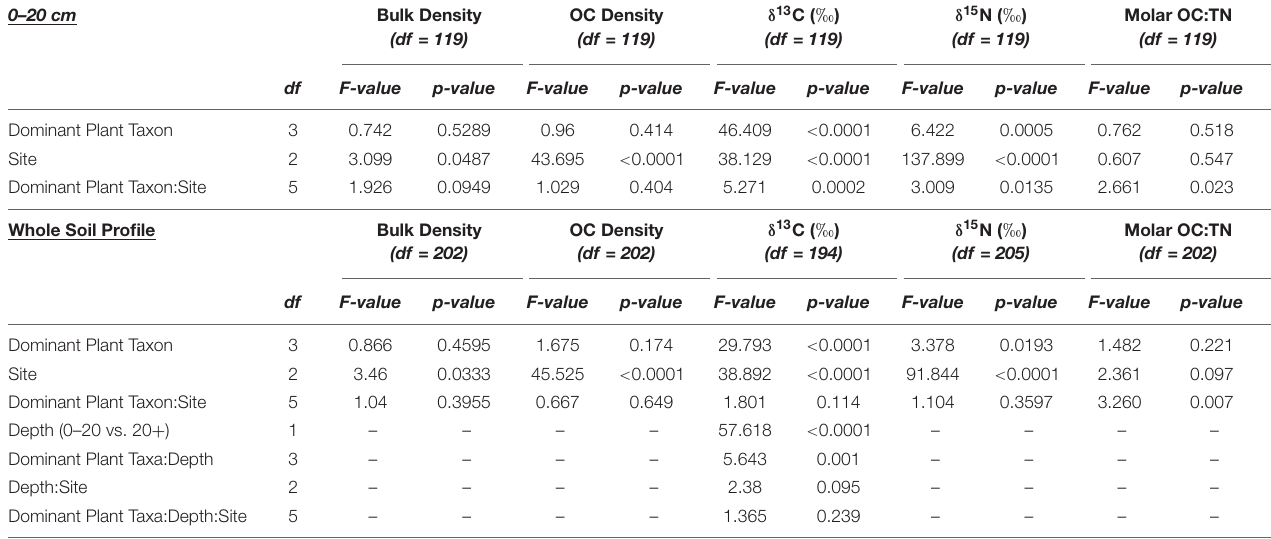
TABLE 2 | Degrees of freedom (df), F -values, and p -values associated with the linear model, separated by parameter. 0–20 cm